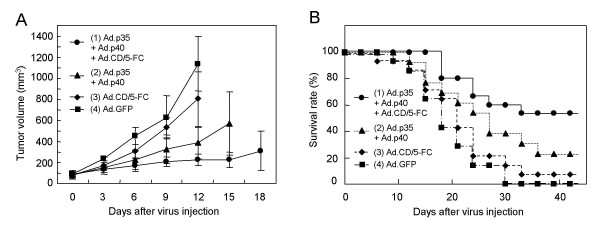
The antitumor activity effected by IL-12 gene transfer increases in vivo when combined with cytosine deaminase/5-FC. (A) Renca tumors were established in BALB/c mice by s.c. inoculation of 1.5 × 105 cells. When the tumors reached 5–6 mm diameter, the animals were randomly divided into four treatment groups (n = 15 per group) and injected once intratumorally with (1) Ad.p35 (2.5 × 108 pfu) plus Ad.p40 (2.5 × 108 pfu) plus Ad.CD (5 × 108 pfu), or (2) Ad.p35 (5 × 108 pfu) and Ad.p40 (5 × 108 pfu), or (3) Ad.CD (1 × 109 pfu), or (4) Ad.GFP (1 × 109 pfu). Mice treated with Ad.CD were given 5-FC (400 mg/kg) intraperitoneally daily for 10 days. Graphic representations of mean tumor growth rates are shown. Bars indicate SD. (B) Mouse survival until day 42 was recorded. Mice were sacrificed and considered as death when tumor size exceeded 1.5 cm in long and short axes. The mean survival times (± SD) were 33.2 ± 10.4 days for (1) group, 27.2 ± 10.9 days for (2) group, 21.9 ± 9.1 days for (3) group, and 19.7 ± 7.1 days for (4) group. The difference between (1) and (2) groups was statistically significant (p < 0.0018) by Student's t test. The treatment outcome is summarized in Table 1. One animal in each of the groups treated with Ad.CD and Ad.GFP succumbed to toxicity, and two mice in the group treated with Ad.p35 plus Ad.p40 were excluded owing to peritoneal metastasis.